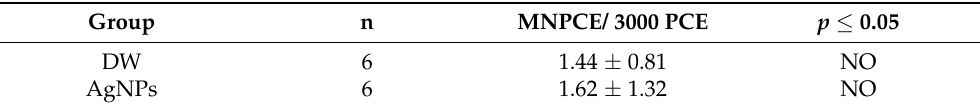
Table 2. Micronucleated polychromatic erythrocytes (MNPCE) in 3000 polychromatic erythrocytes (PCE) from peripheral blood.